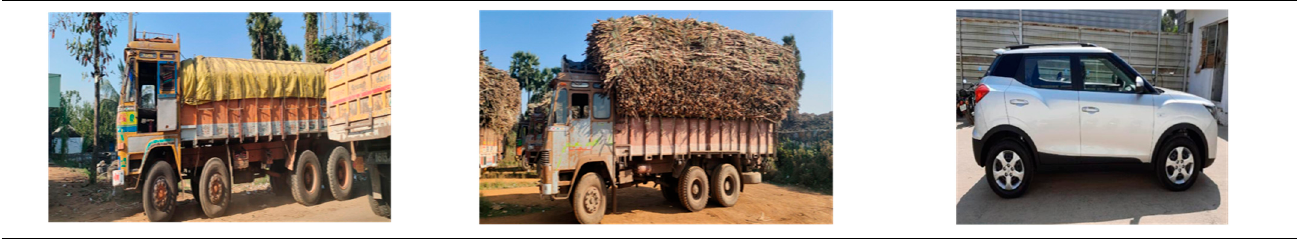
Table 3. Preview of images belonging to their respective classes.